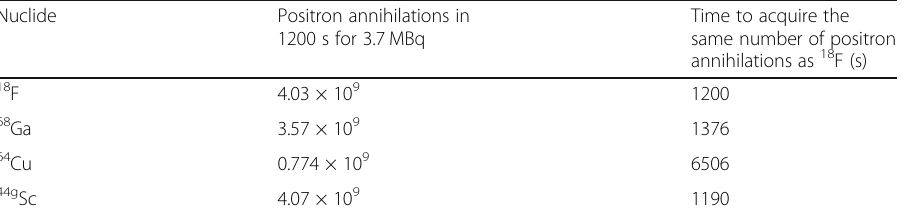
Table 2 Number of decays expected in standard scan conditions and time used to acquire an equal amount of positron decays for each